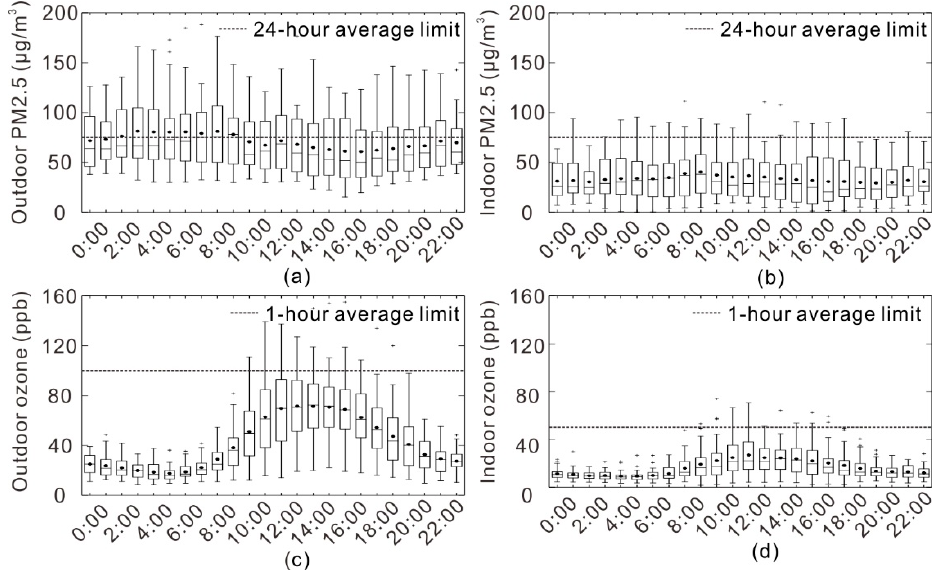
Figure 7. ( a ) Outdoor PM2.5 levels at different time periods during the 37 day experiment period; ( b ) Indoor PM2.5 levels at different time period during the 37 day experiment period; ( c ) Outdoor ozone levels at different time period during the 37 day experiment period; ( d ) Indoor ozone levels at different time period during the 37 day experiment period.